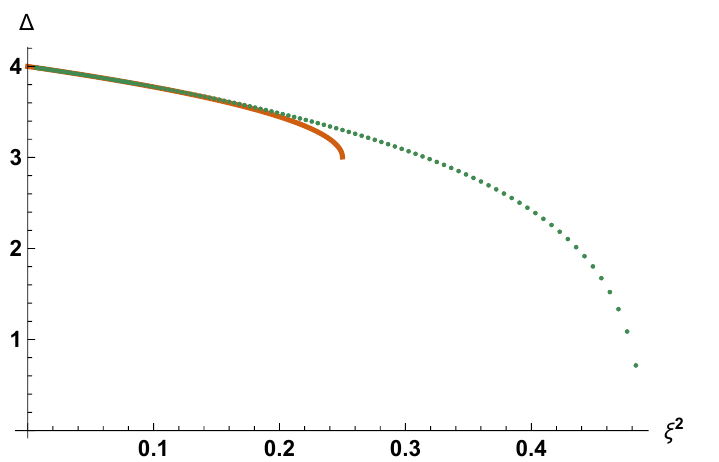
Figure 10 . Numerical solution (dots) and the Asymptotic Bethe Ansatz prediction (solid line) match perfectly at small coupling for the state with one magnon and J = 3. The two start to deviate from each other at larger values of (cid:24) 2